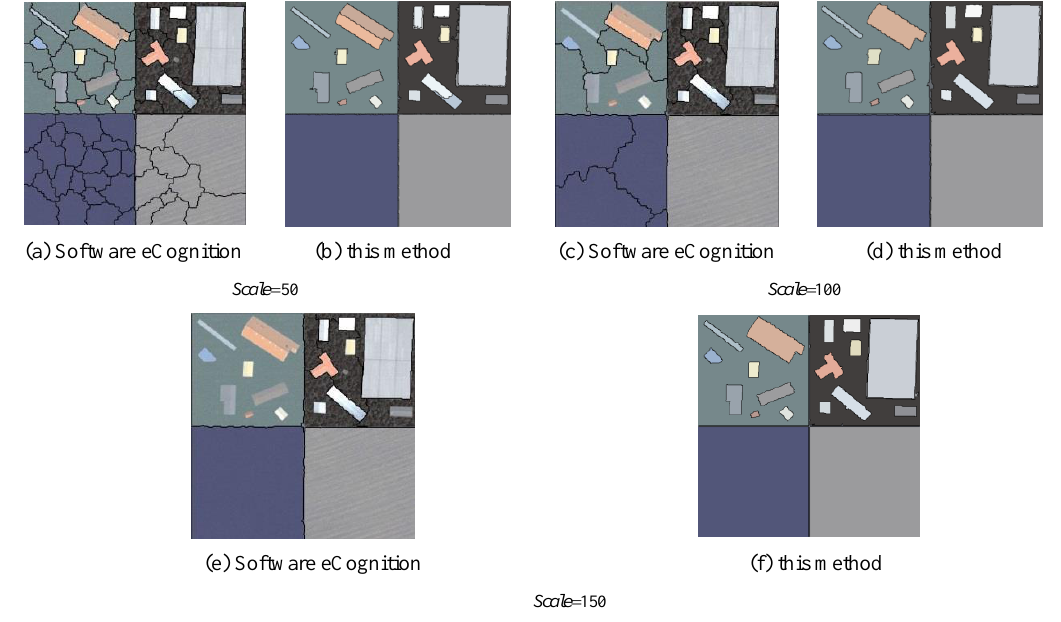
Figure 4. Segmentation results of the analog image